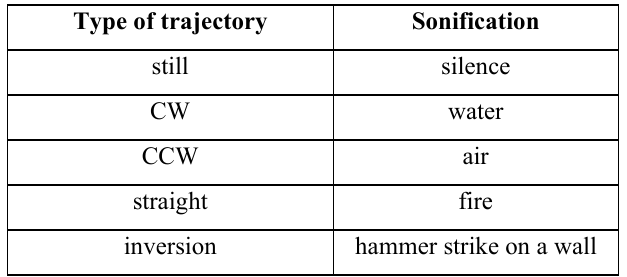
Table 2. Another mapping example between trajectory gestalts and sound